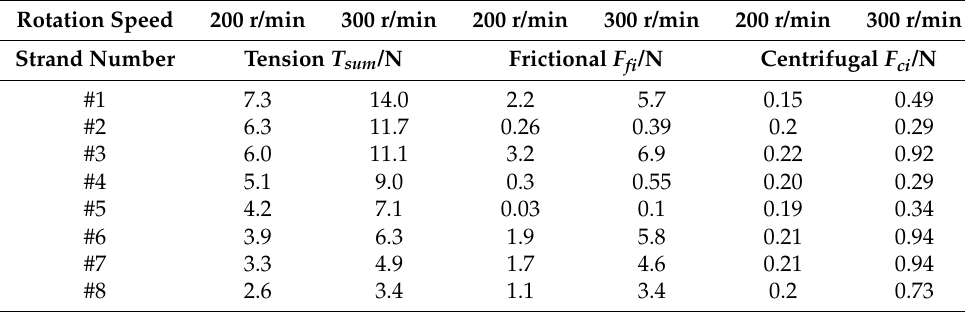
Figure 7. The relative position relationship between the winding wheel and the sensor. Table 3. Analysis of the initial state of each strand under different speeds.